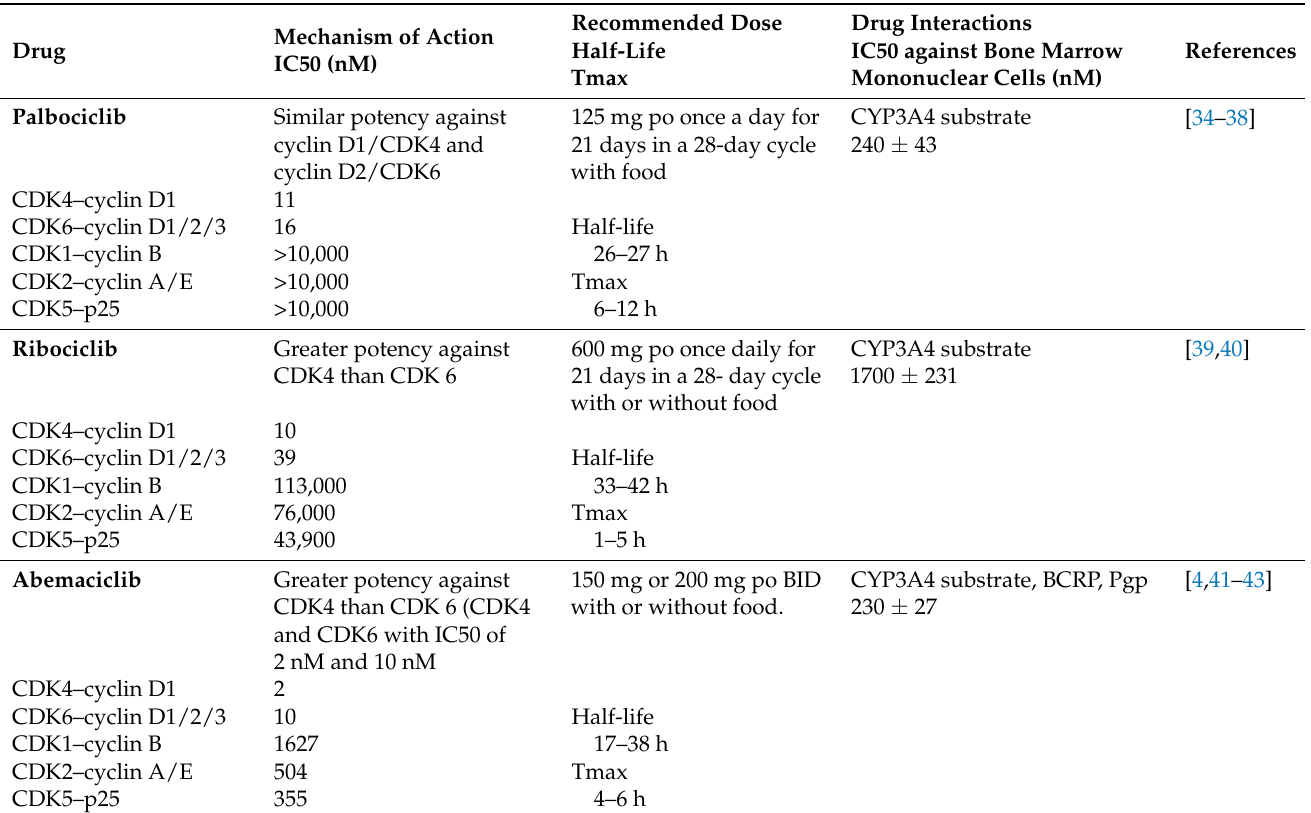
Table 1. Summary of FDA approved CDK4/6